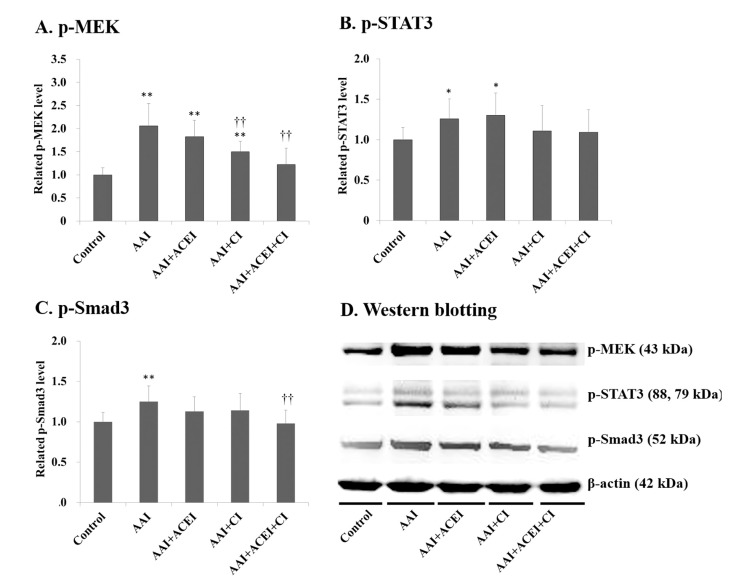
The level of inflammatory signaling pathways in the kidneys of mice with AAI-induced acute nephropathy.The expression of p-MEK (A), p-STAT3 (B) and p-Smad3 (C) in kidney tissues was determined using Western blotting and representative results of Western blotting are shown (D). All values are expressed as the means ± SD from each group (n = 9). * and ** indicate p < 0.05 and p < 0.01 compared to the Control group, respectively; †† indicates p < 0.01 compared to the AAI group.